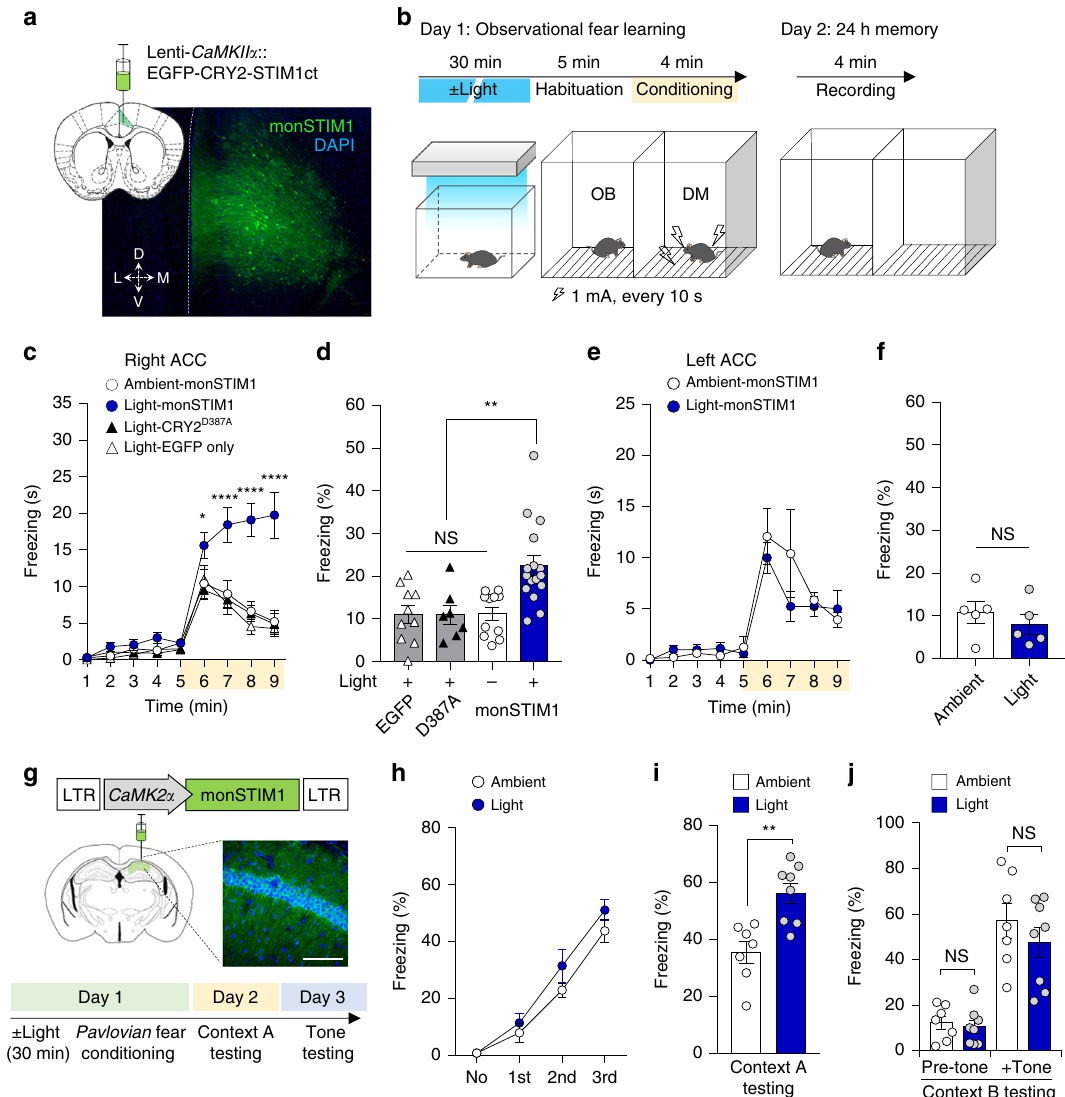
Fig. 3 Effects of non-invasive optical Ca 2 + modulation on speci fi c mice behaviors. a Image showing representative histology sample of right ACC expressing monSTIM1. b Schematic depiction of observational fear learning paradigm. OB, observer mouse. DM, demonstrator mouse. c Summary data showing average time for freezing. Yellow box indicates the time window for foot-shock administration. (* P < 0.05, **** P < 0.0001; P value was determined by one-way ANOVA). d Graph describing the percentage of time spent freezing during the 24-hour memory test (** P < 0.01, NS = Not signi fi cant; Tukey ’ s tests). e Graph showing average time for freezing with mice expressing monSTIM1 at left ACC on acquisition of observational fear (Day 1). f Graph indicating the percentage of time spent freezing during 24-hour memory test (NS = Not signi fi cant; Student two-tailed t test). g Image showing fl uorescence image of histology of right CA1 hippocampus (Blue, DAPI; Green, OptoSTIM1; Scale bar, 50 μ m) with schematic depiction of conducted fear conditioning experiment. h – j Graphs showing the percentage of freezing behavior of mice at each training points during fear conditioning h , at 24-hour contextual memory test i , and at 48-hour post training with tone memory test j . (** P = 0.002 for light-illuminated versus ambient; NS = Not signi fi cant